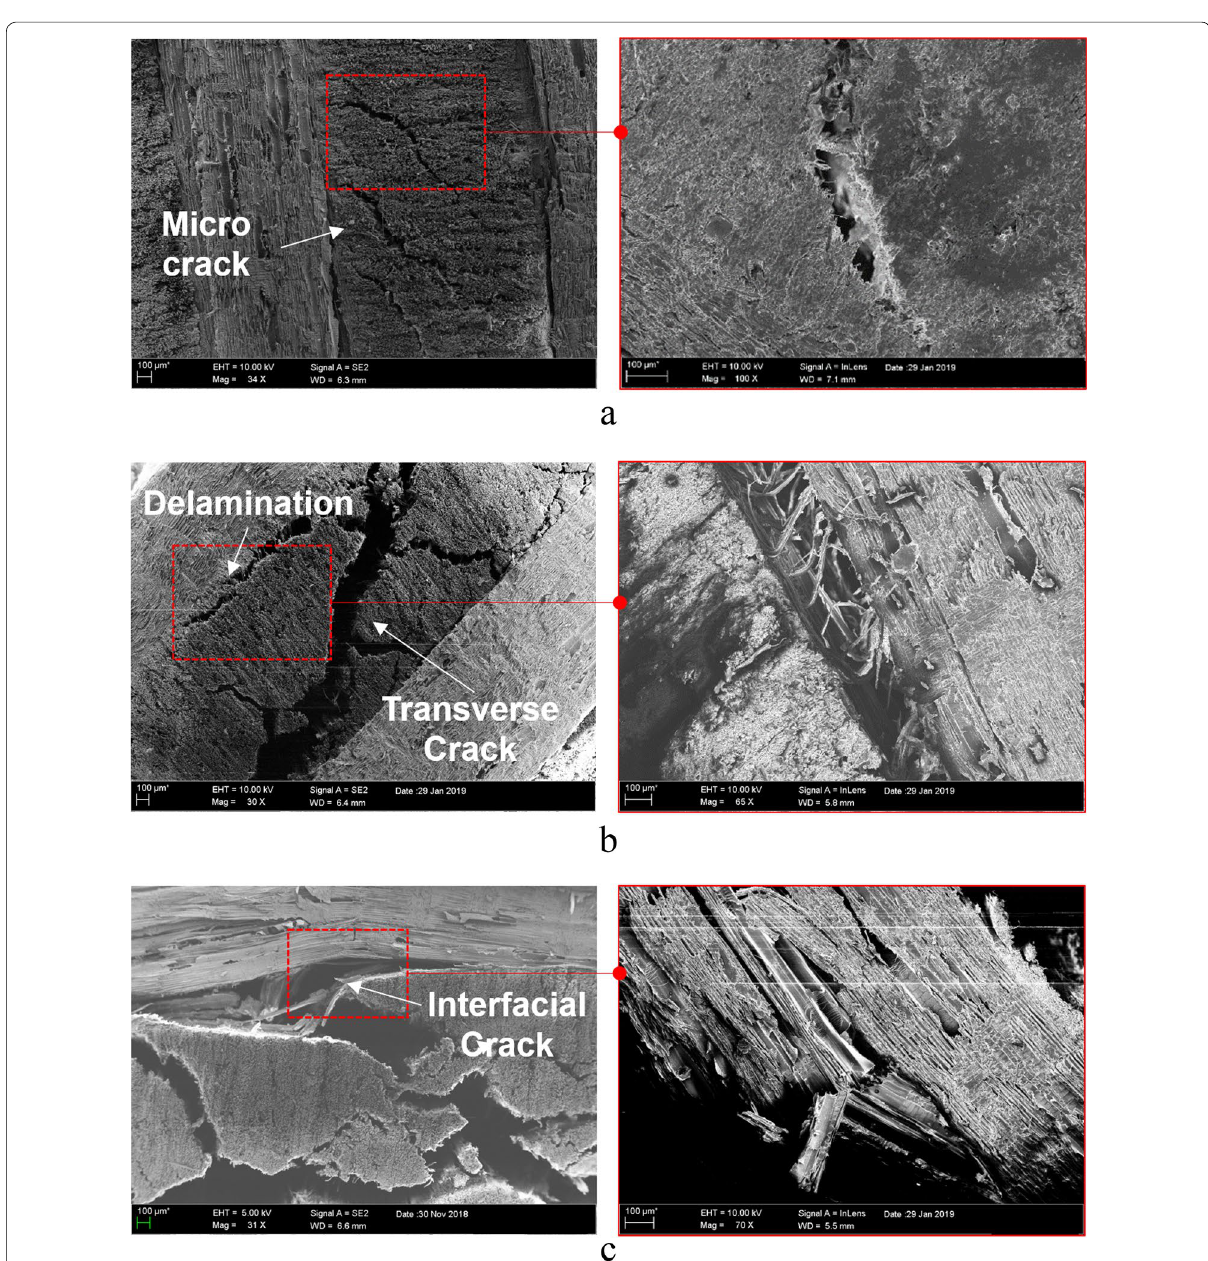
Fig. 17 SEM images of plywood specimens at different temperature regimes: a ambient temperature and low temperature, b low temperature and cryogenic temperature, and c cryogenic